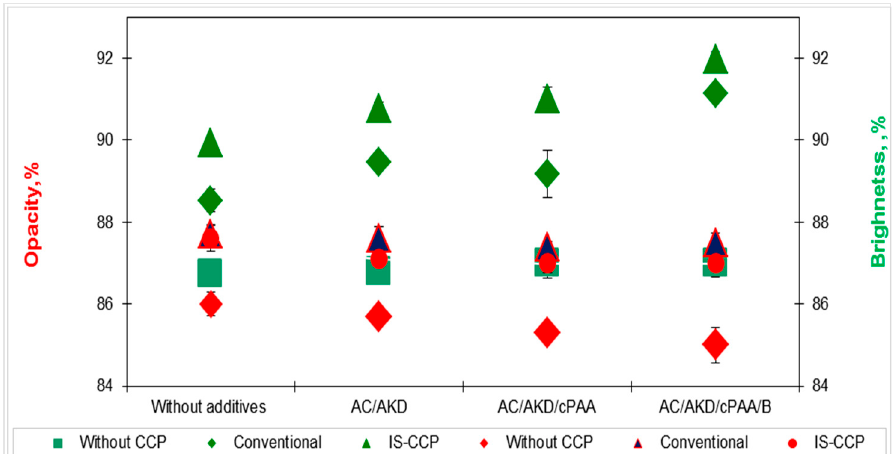
Figure 8. Evolution of brightness ( ♦ , ▲ , ● ) and opacity ( ■ , ♦ , ▲ ) for different additive systems in relation with paper composition.